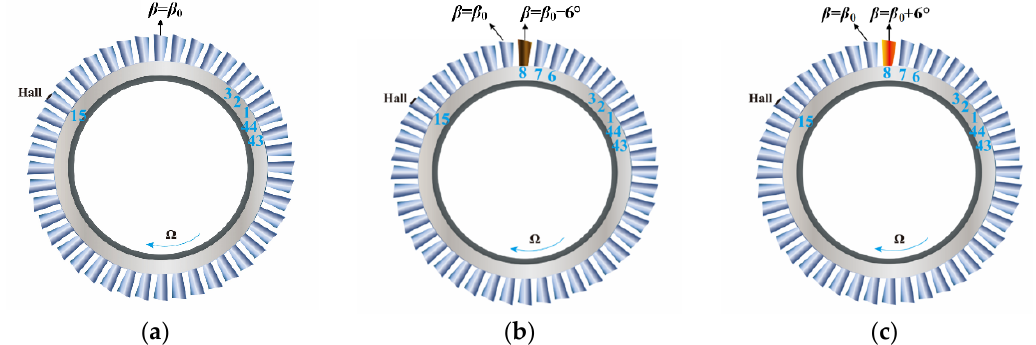
Figure 4. Schematic diagram of the three stagger angle settings in the experiment: ( a ) stagger angle setting of Case 0; ( b ) stagger angle setting of Case 1; ( c ) stagger angle setting of Case 2.